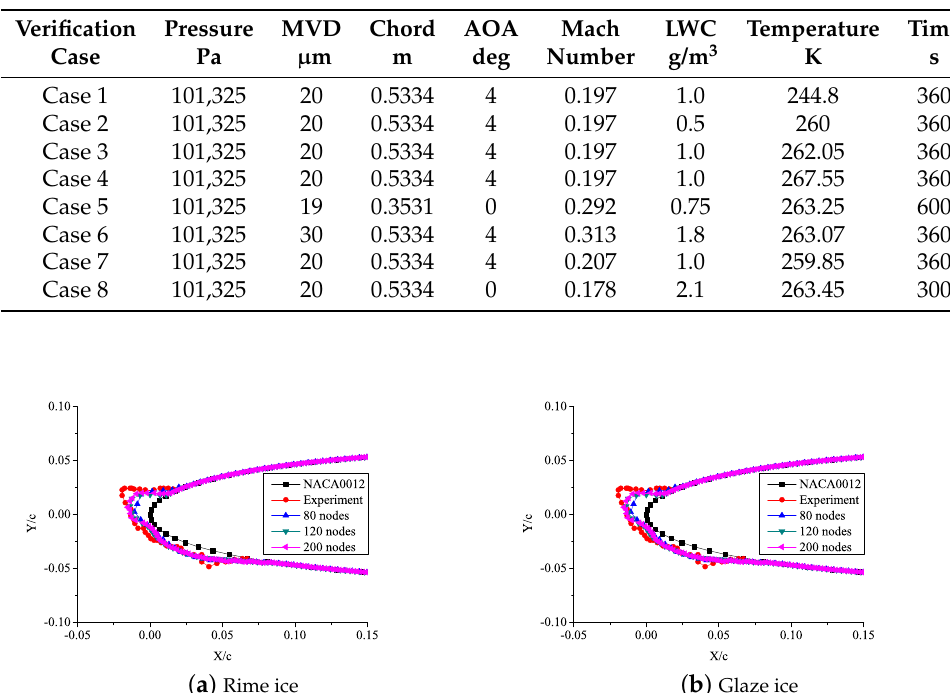
Table 1. Icing conditions for verification cases.